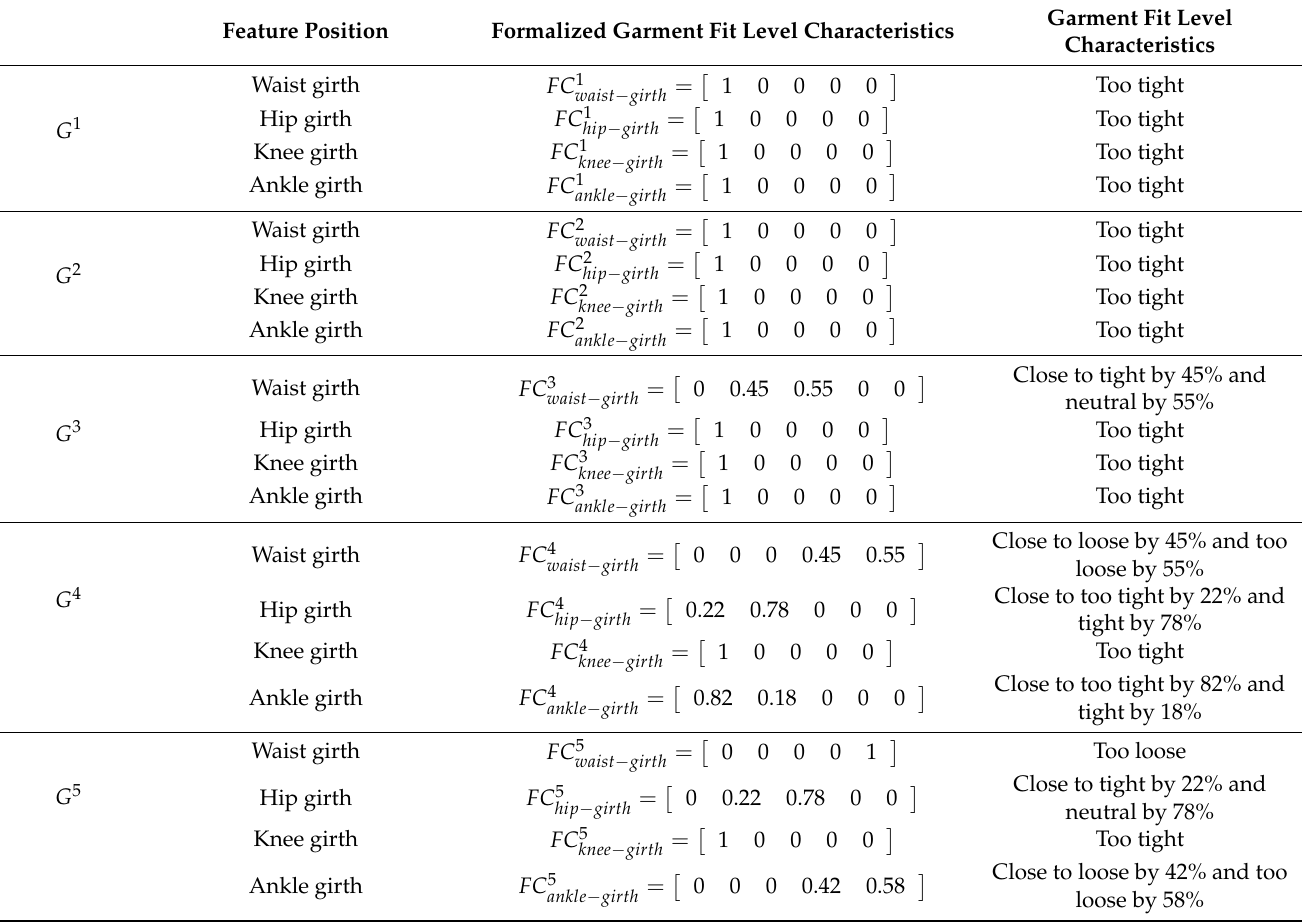
Table 4. The characteristics of the garment fit levels.